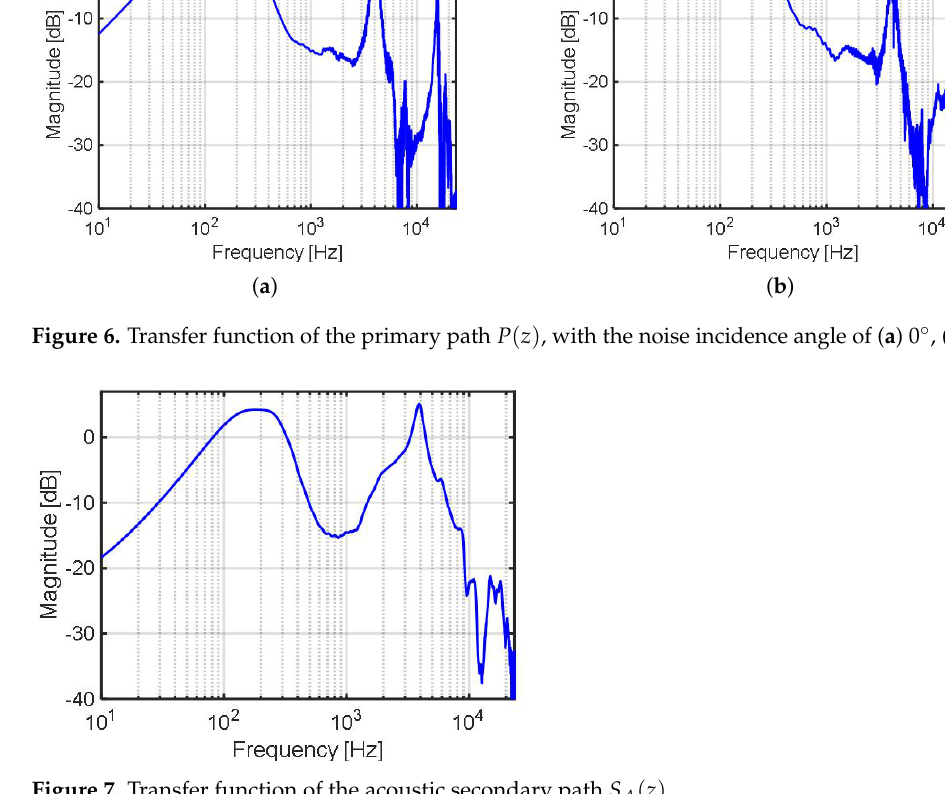
Figure 7. Transfer function of the acoustic secondary path S A ( z )